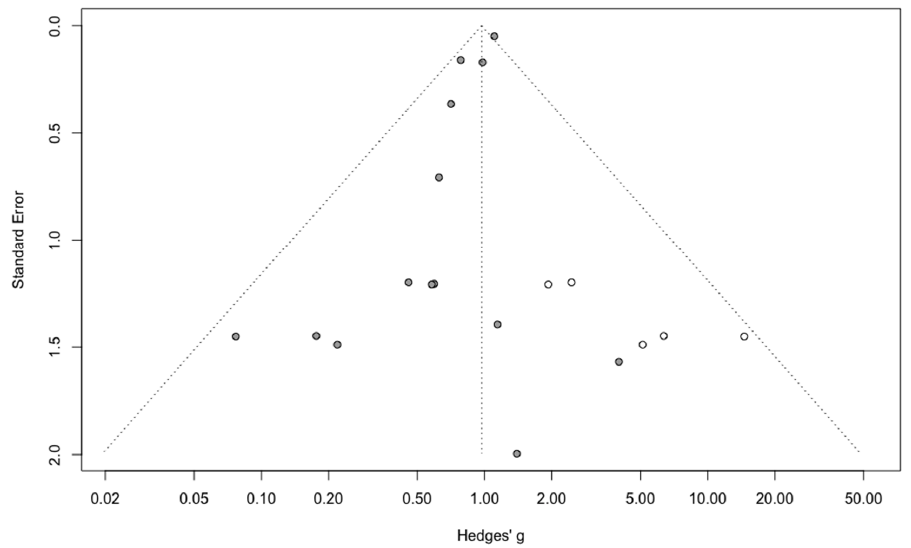
Figure 3. Corrected funnel plot for three ‐ year mortality outcome.